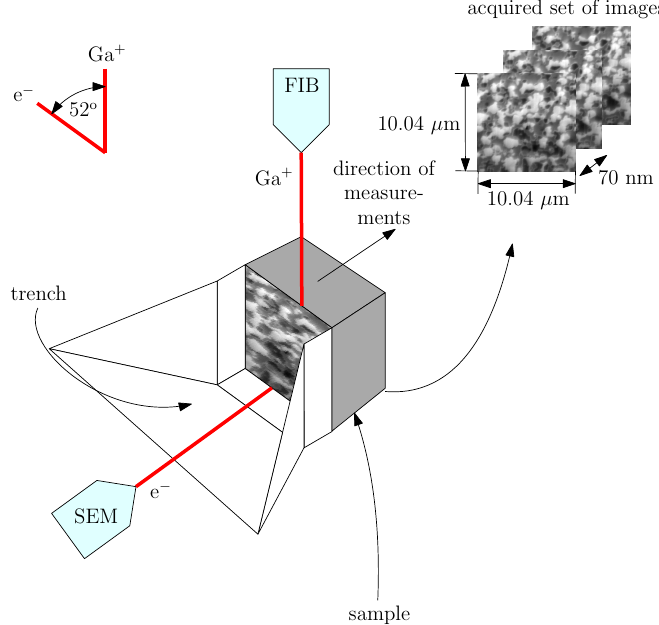
Figure 4. Configuration of the FEI Versa 3D FIB-SEM